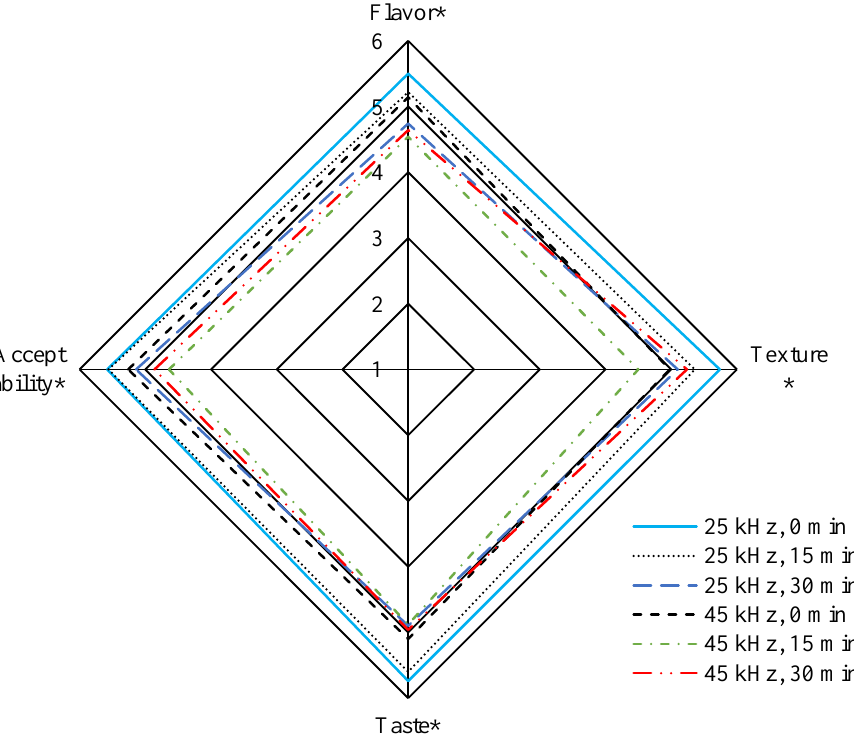
Figure 7. Effect of the application of high-intensity ultrasound at 25 or 45 kHz for 0, 15, or 30 min on the sensory acceptance of Oaxaca cheese. * Indicates significant differences between treatments ( p < 0.05).